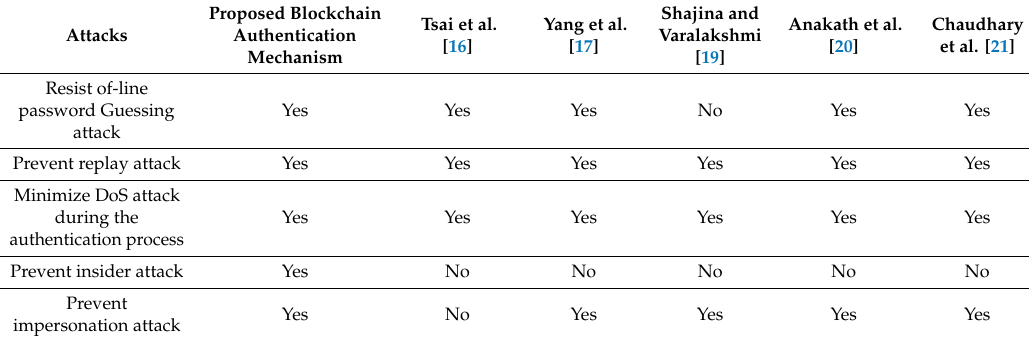
Table 3. The security comparison of the proposed scheme and other related authentication scheme’s.